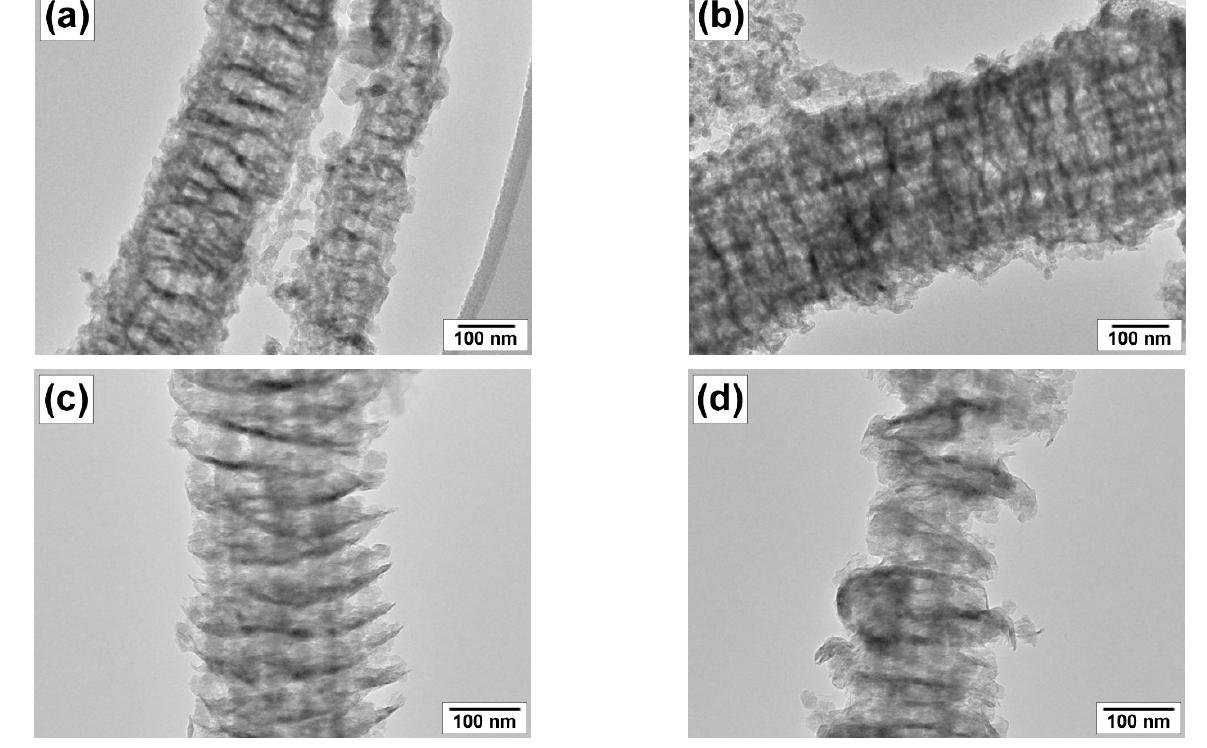
Figure 13. HR TEM images of the carbon product obtained by the decomposition of TCE at 600 °C over catalysts: ( a , b ) 100Ni; ( c , d ) 96Ni-4W.